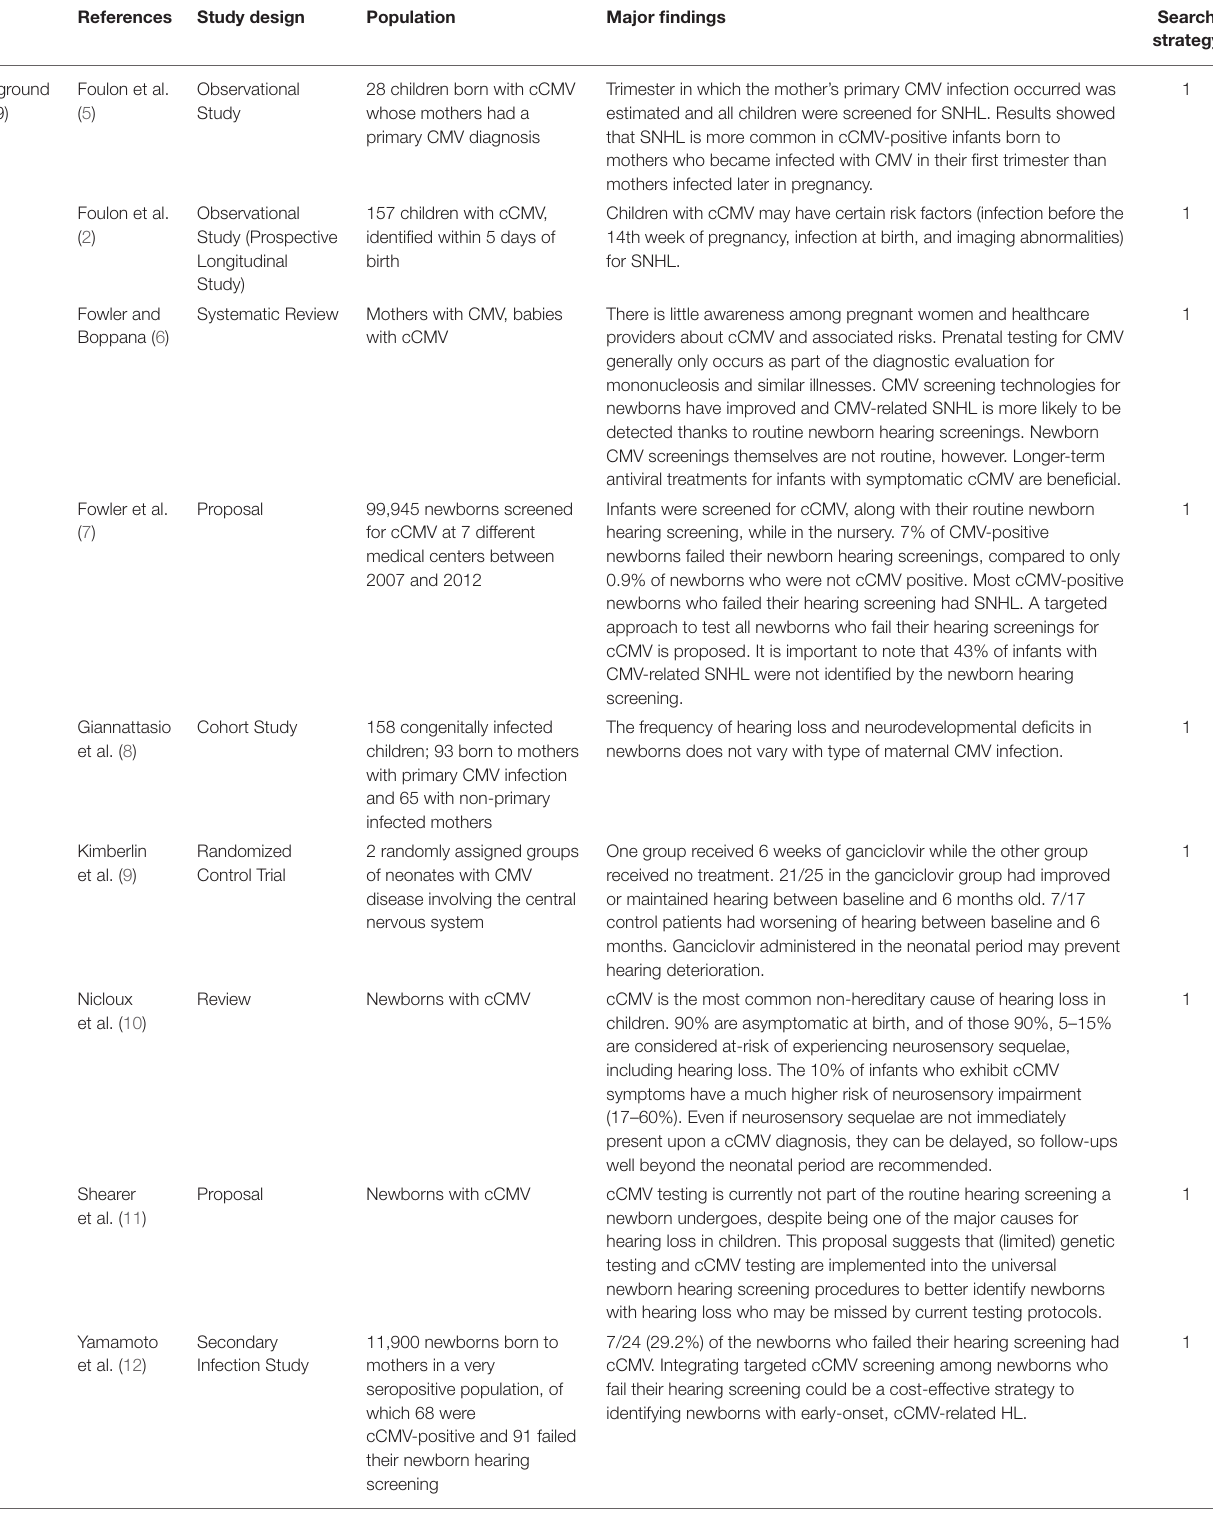
TABLE 1 | Background of CMV and effects of CMV on hearing, speech and language development, and clinical outcomes in